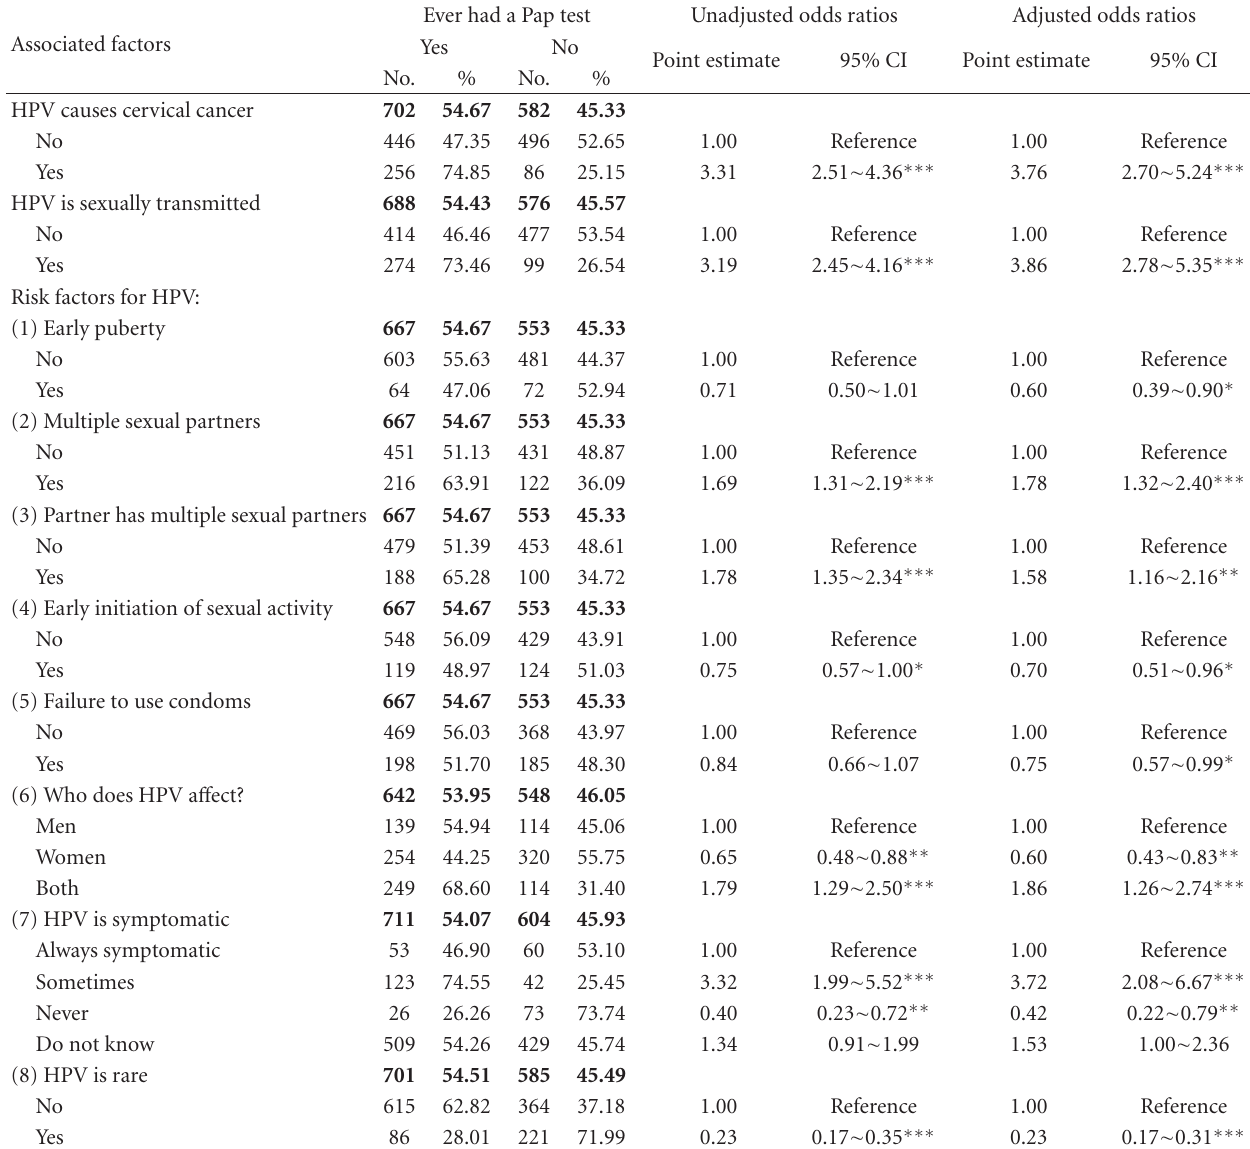
Table 4: Associations between Papanicolaou (PAP) testing and HPV-specific knowledge. Associated